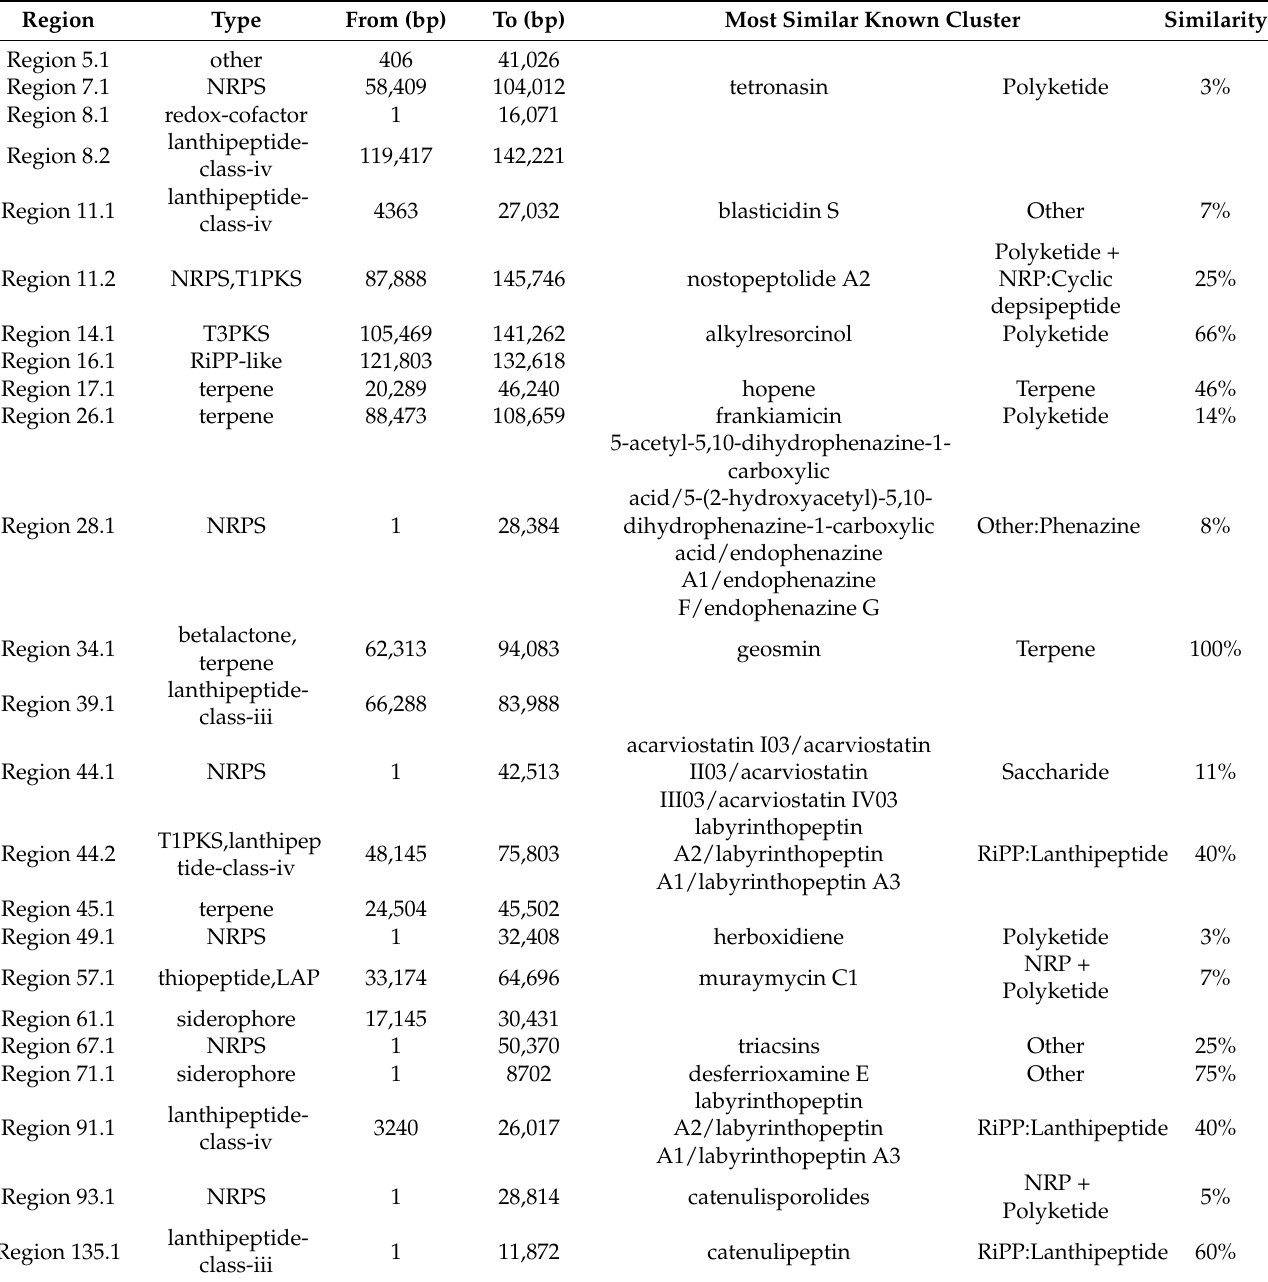
Table A5. Microtetraspora sp. AC03309 secondary metabolite biosynthetic gene clusters (BGCs) were predicted using AntiSMASH 6.0.